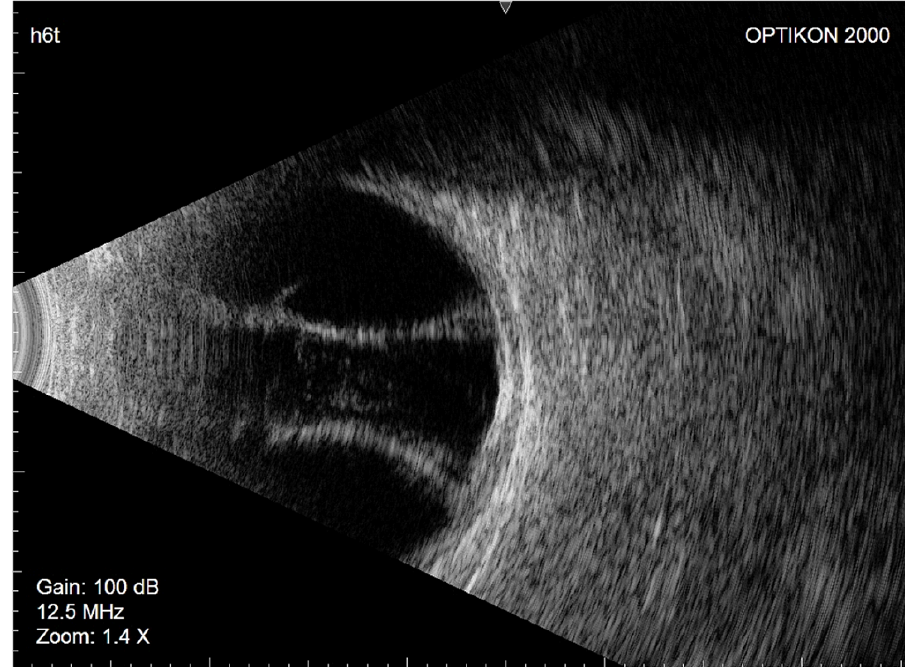
Figure 2. Right eye Eco-B scan showing serous choroidal detachment.